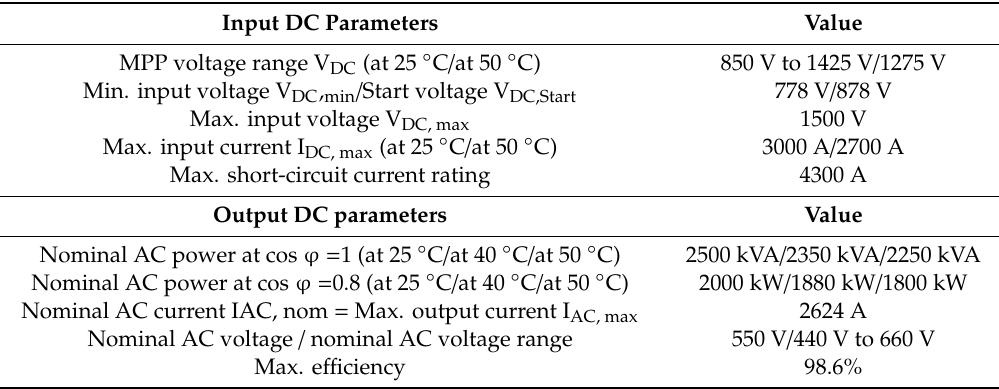
Table 5. The technical details of the selected